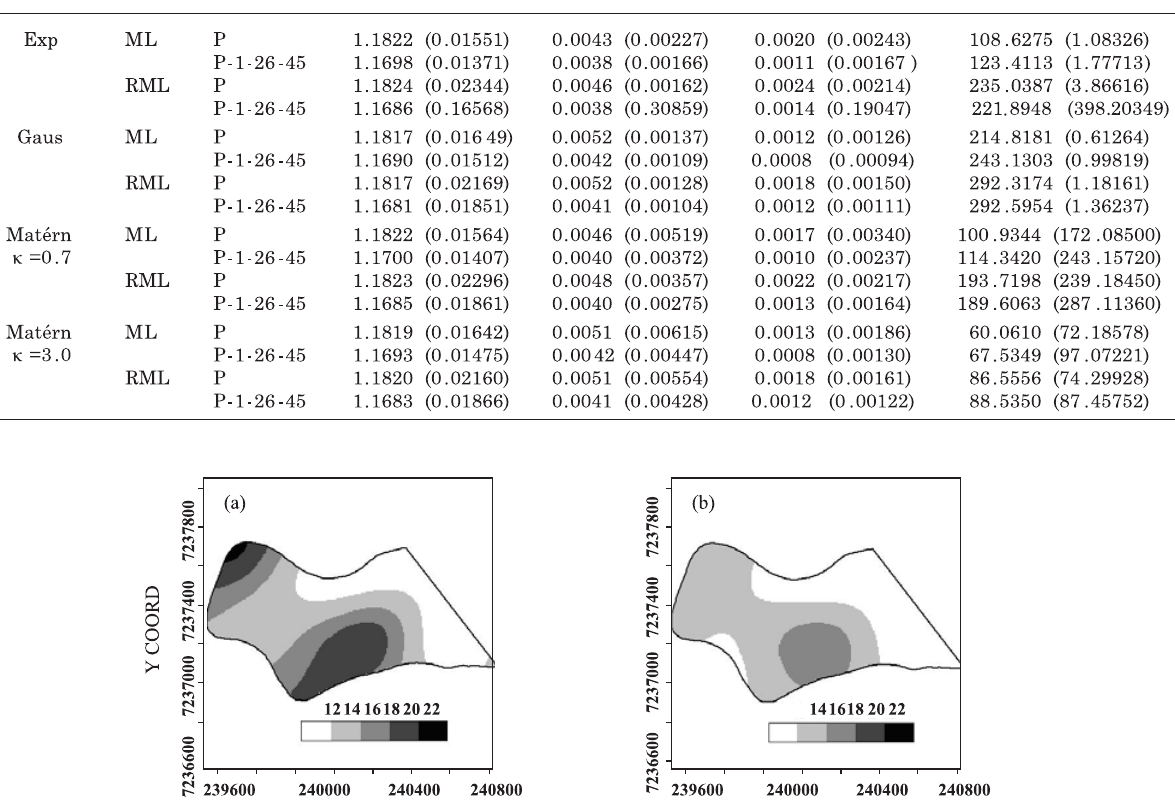
Figure 11. Thematic maps: (a) With original data (P); (b) Elimination of the observations 1, 26 and 45